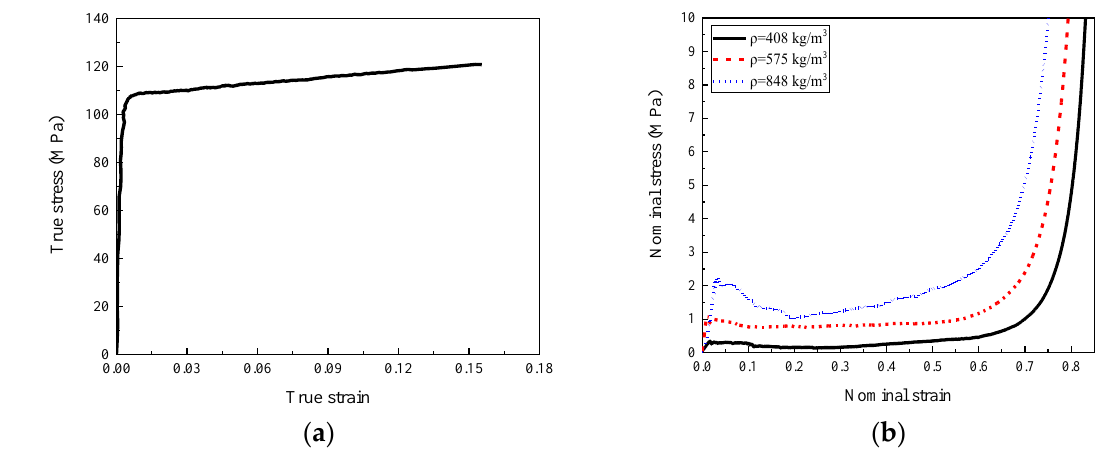
Figure 4. The stress–strain relationships under quasi-static loading: ( a ) coupon of honeycomb cell-wall material under tension of loading rate 0.5 mm/min; ( b ) foam concrete under compression of loading rate 0.5 mm/min.